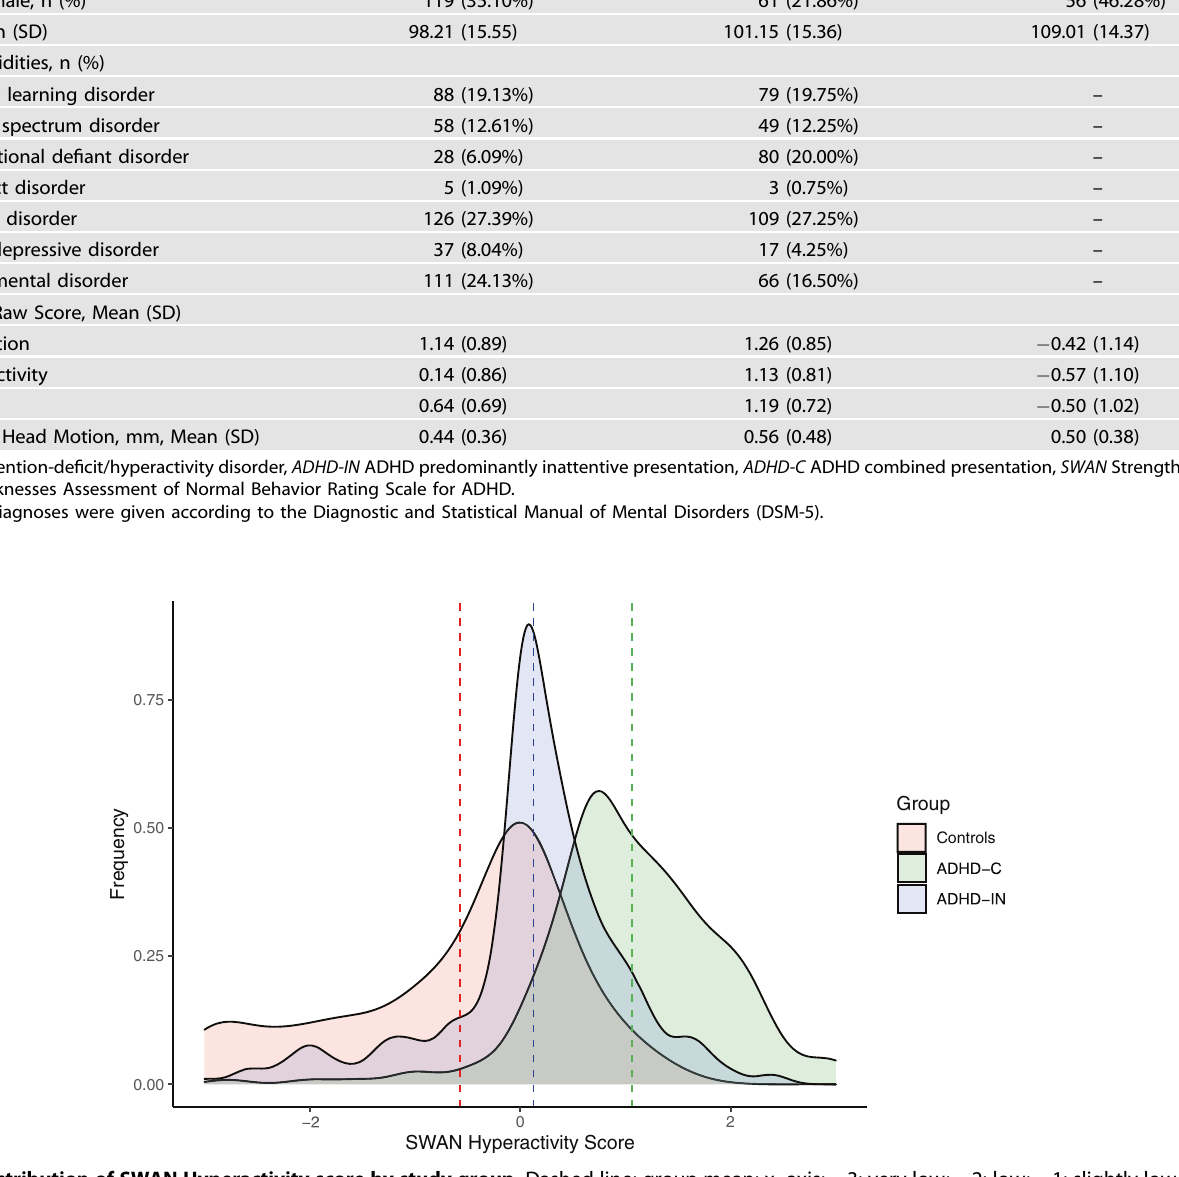
Fig. 1 Distribution of SWAN Hyperactivity score by study group. Dashed line: group mean; x- axis: − 3: very low; − 2: low; − 1: slightly lower; 0: average; 1: slightly higher; 2: high; 3: very high. ADHD, attention-de fi cit/hyperactivity disorder; ADHD-IN, ADHD predominantly inattentive presentation; ADHD-C, ADHD combined presentation; SWAN, Strengths and Weaknesses Assessment of Normal Behavior Rating Scale for ADHD.